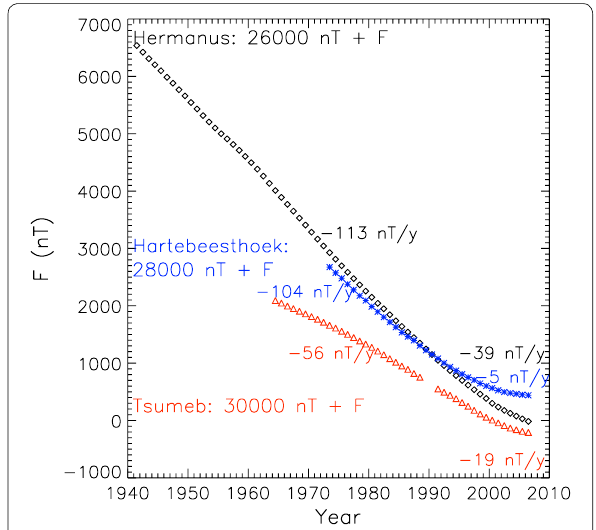
Fig. 1 The long-term decrease in total field intensity over south- ern Africa. Evolution of total field intensity from 1940 to 2010 at Hermanus (HER), Hartebeesthook (HBK) and Tsumeb (TSU) magnetic observatories in southern Africa. There is a decrease of 20% of total field intensity at Hermanus between 1940 and 2010